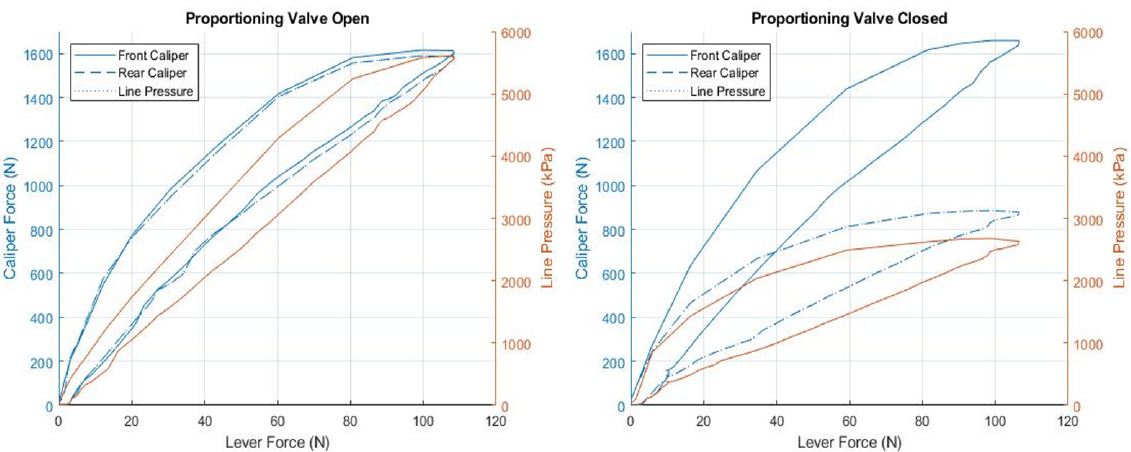
Figure A3. Caliper compression force and system pressure as a function of lever force for the prototype with the proportioning valve open ( left ) and closed ( right